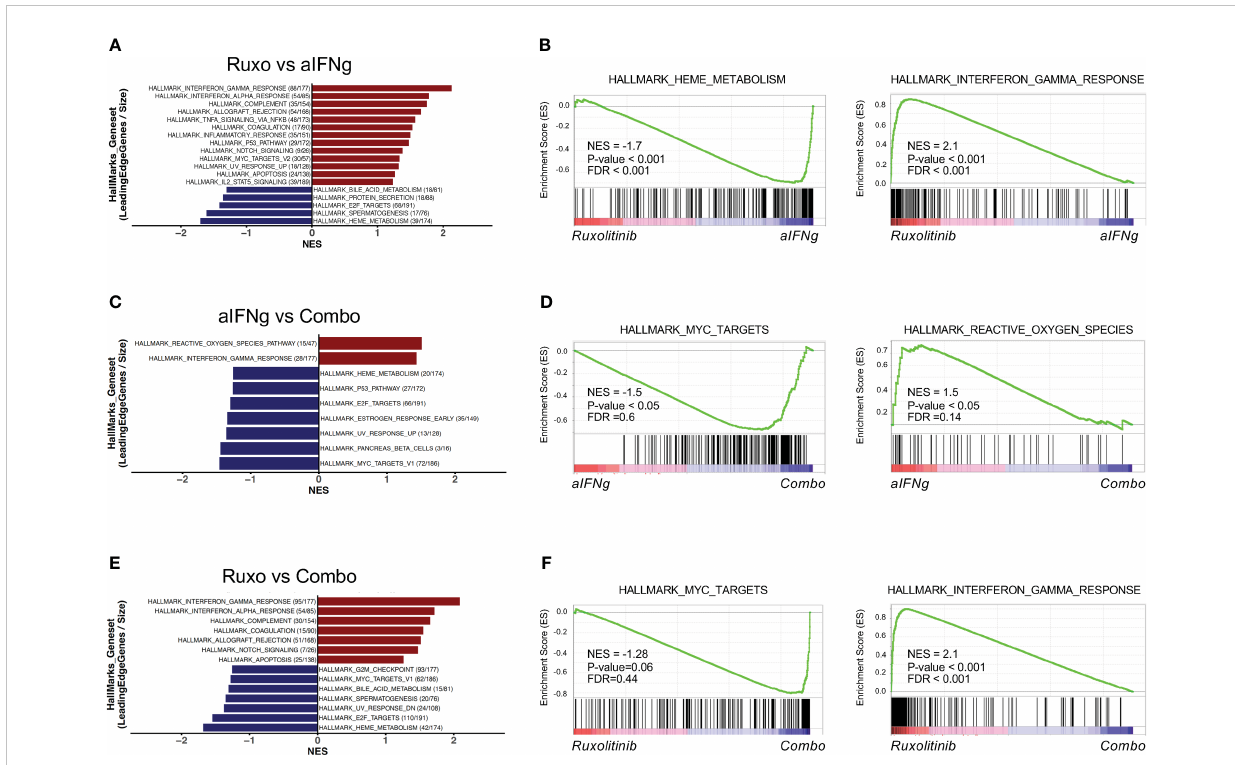
FIGURE 5 Top hallmark pathways in splenic CD8 T cells from Prf1 − / − mice infected with LCMV and treated with aIFNg, ruxolitinib, or combination treatment. Bar graphs of GSEA demonstrating the most signi fi cant (P-value < 0.05 or P-value < 0.1 & NES >1) hallmark gene sets in CD8 T cells from LCMV- infected mice treated with ruxolitinib vs. aIFNg (A) , aIFNg vs. combination therapy (C) , or ruxolitinib vs. combination therapy (E) . Enrichment plots highlighting the most signi fi cant pathways downregulated or upregulated with ruxolitinib vs. aIFNg (B) , aIFNg vs. combination therapy (D) , or ruxolitinib vs. combination therapy (F)